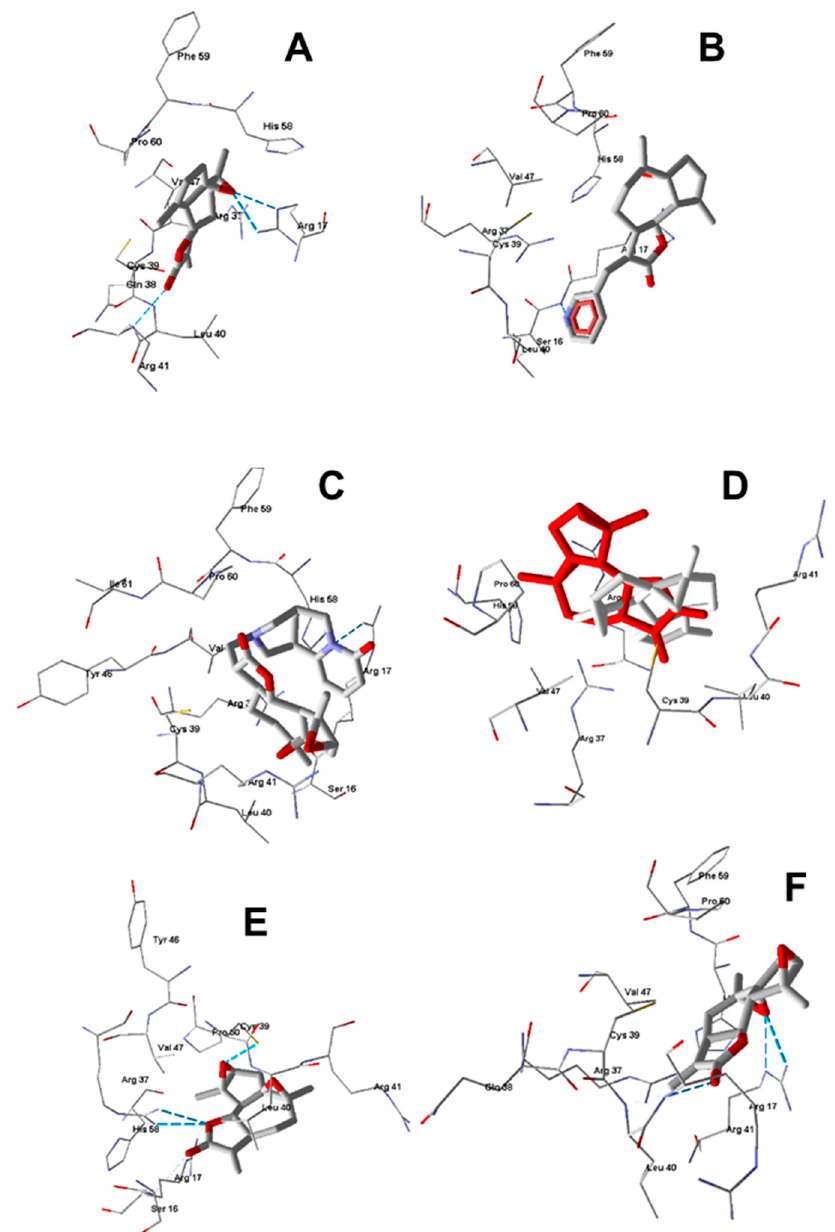
Figure 4. Docking poses of arglabin and its semi-synthetic derivatives in the ZAP-70 SH2 module. Panel ( A ) Docking pose of arglabin ( 1 ). Panel ( B ) Docking pose of pyridinyl arglabin ( 1c ). Panel ( C ) Docking pose of cytisinyl epoxyarglabin ( 1d ). Panel ( D ) Superposition of docking poses of α -epoxyarglabin ( 1a ; red) and β -epoxyarglabin ( 1b ; grey). Panel ( E ) Docking pose of β -epoxyarglabin ( 1b ). Panel ( F ) Docking pose of α -epoxyarglabin ( 1a ). In Panel D, residues within 7 Å of the center of the search space are shown. In all other panels, residues within 4 Å of the pose are shown. H-bonds are shown as blue dashes.